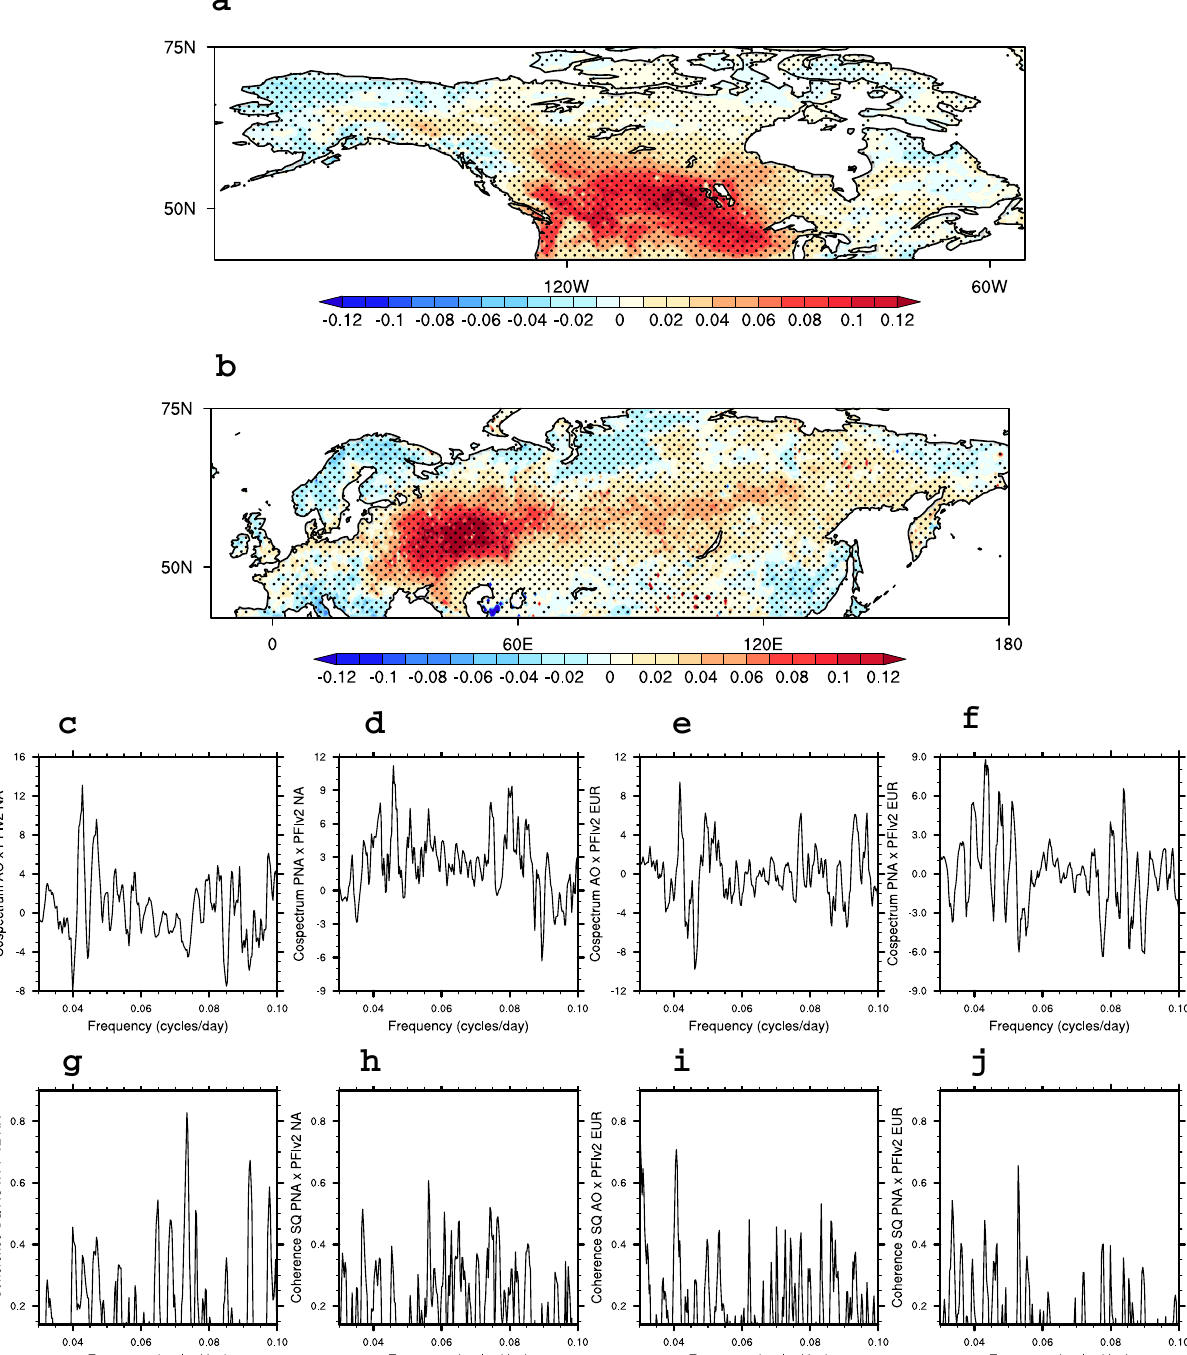
Fig. 4 Dominant PFIv2 pattern and co-spectrum analyses. March – October dominant pattern of PFIv2 as de fi ned by the fi rst EOF ( a , b ) computed over the 20° – 90°N, 0°-360°. The patterns are displayed as amplitudes by regressing regional NA and Eurasia anomalies upon the standardized fi rst principal component time series. Dotted regions are signi fi cant at 95% level. Panels c shows co-spectrum between AO and PFIv2 over NA, d for PNA and PFIv2 over NA, (e) AO and PFIv2 over Eurasia and f PNA and PFIv2 over Eurasia. g – j are the same as c – f but for the coherence